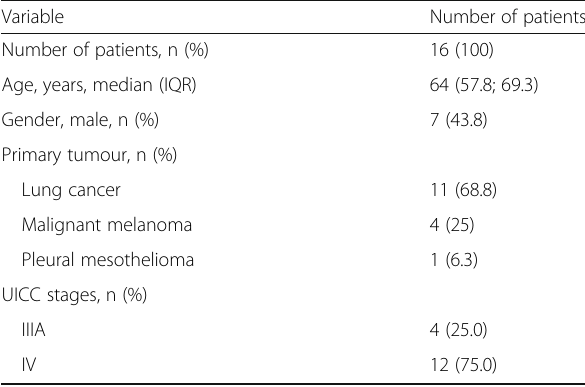
Table 1 Baseline characteristics of patients receiving ICM Variable